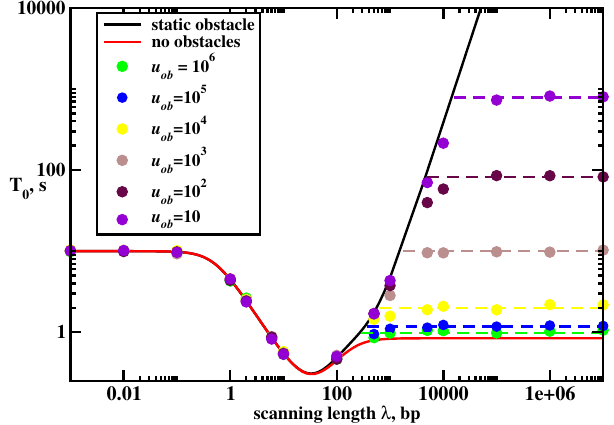
Figure 10. Mean search times to find the target in the system with a mobile crowder on DNA. The DNA chain has L = 1000 sites, and the target is in the middle of the chain, m = L /2. Parameters used for calculations are k on = 0.1 s − 1 , u = 10 5 s − 1 and variable u ob . Solid curves correspond to analytical results for DNA without obstacles and for DNA with a static obstacle, which are averaged over all initial positions of the crowder. Symbols correspond to Monte Carlo computer simulations. Dashed lines describe the approximate theory, as explained in the text. Adapted with permission from Ref.